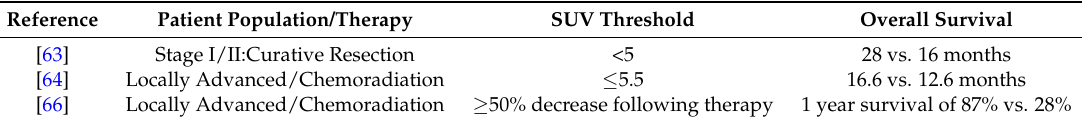
Table 7. Maximum standardized uptake value (SUVmax) and changes in SUVmax correlates with patient therapeutic